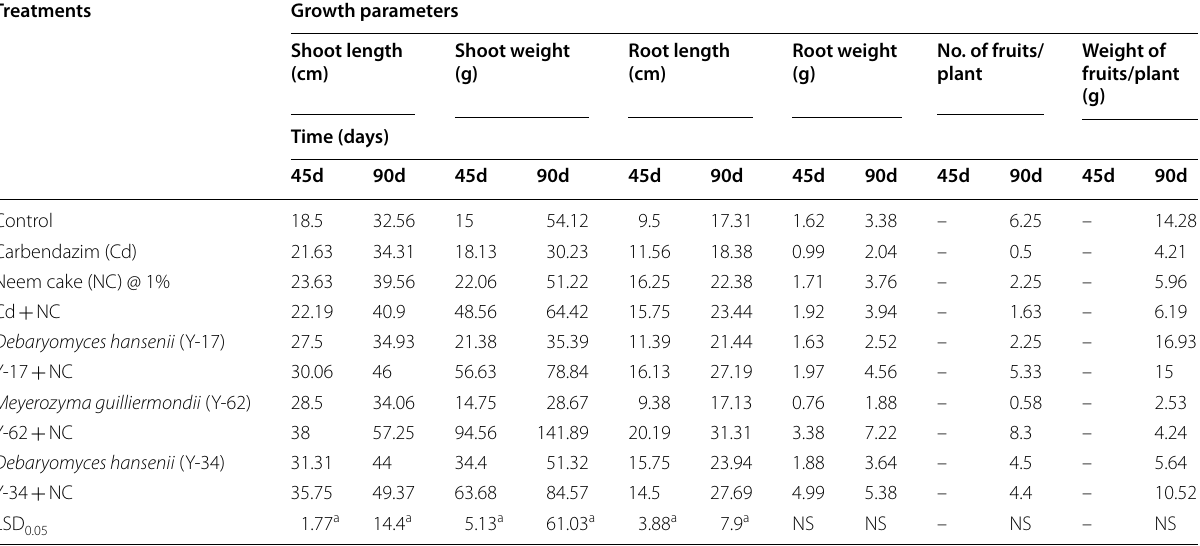
a Mean values in column showing differences greater than LSD values are significantly different at p <